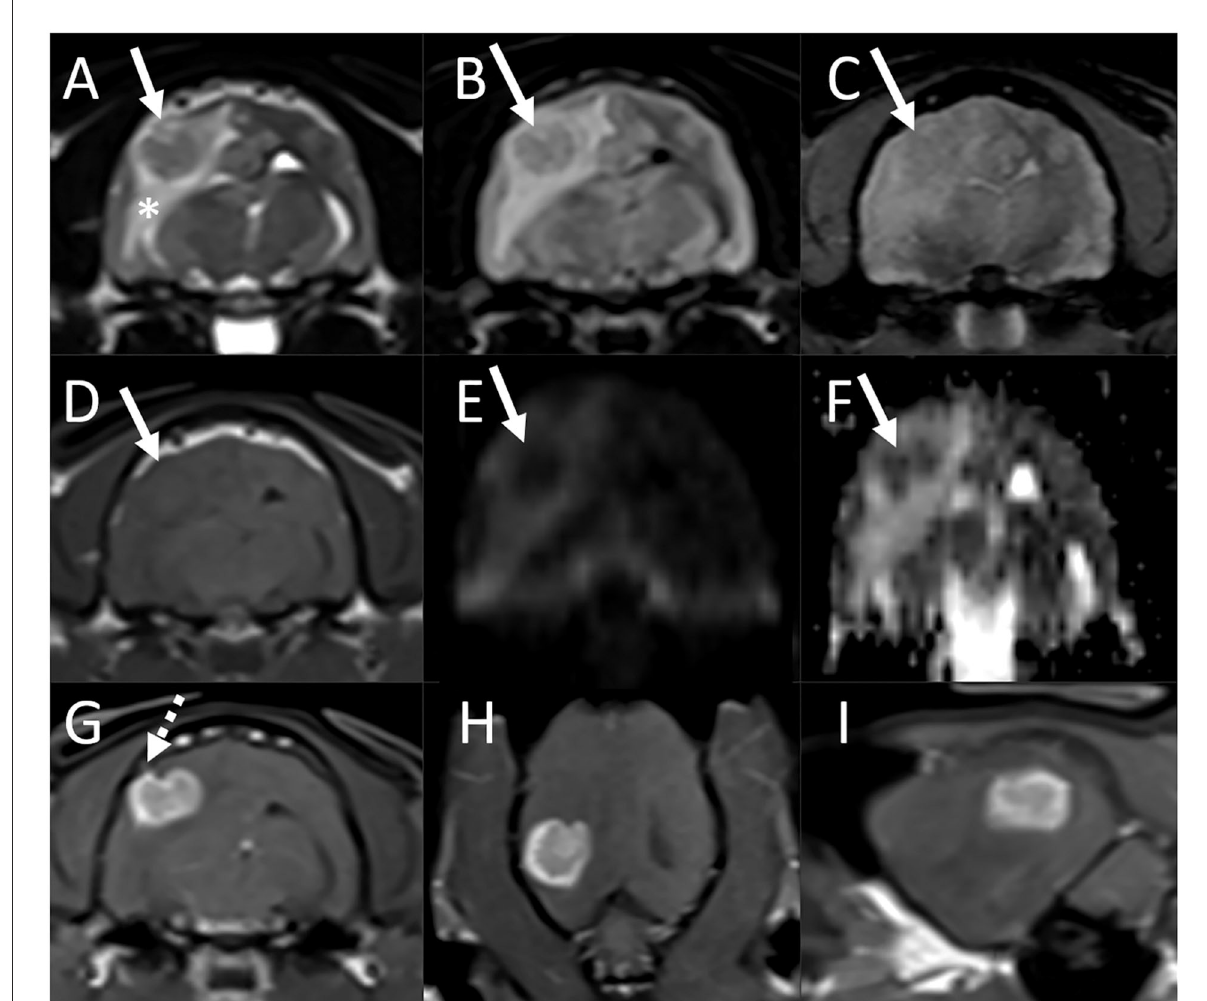
FIGURE4 Brain MRI in an estimated 7-year-old cat (Case 3) with presenting complaints of head pressing and progressive neurologic deficits. Transverse T2-weighted (A) , T2-FLAIR (B) , T2*-weighted GRE (C) , T1-weighted (D) , diffusion-weighted imaging [DWI, (E) ] and corresponding ADC map (F) , and postcontrast T1-weighted images in the transverse (G) , dorsal (H) , and sagittal (I) planes. (A)–(F) There is an ≈ 1-cm diameter mass associated with the periphery of the right temporal lobe, in contact with the dural surface (arrows). The lesion is T2, T2-FLAIR, and T1 iso- to mildly hypointense to gray matter [ (A) , (B) , (D) ], is not associated with susceptibility artifact on T2*-weighted image (C) , and is hypointense both on DWI and ADC maps [ (E) and (F) ]. There is marked perilesional T2 hyperintensity extending along the white matter tracts of the right cerebral hemisphere, consistent with vasogenic edema, resulting in compression of the right lateral ventricle, and a midline shift toward the left. A small volume of fluid is present in the nasopharynx, considered incidental. (G)–(I) Following contrast medium administration, the mass shows strong and fairly homogeneous contrast enhancement. The majority of the lesion is centered on brain parenchyma, with acute angles between the ventral, rostral, and caudal aspects of the mass and the calvarium. At the dorsal aspect of the mass, there is mild focal thickening and contrast enhancement of the pachymeninges [ (G) , dashed